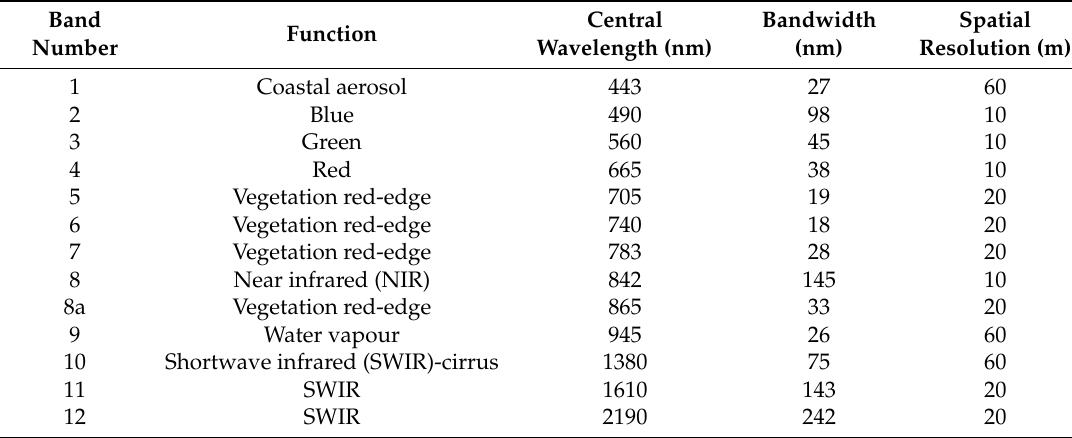
Table 1. Sentinel-2 bands setting.